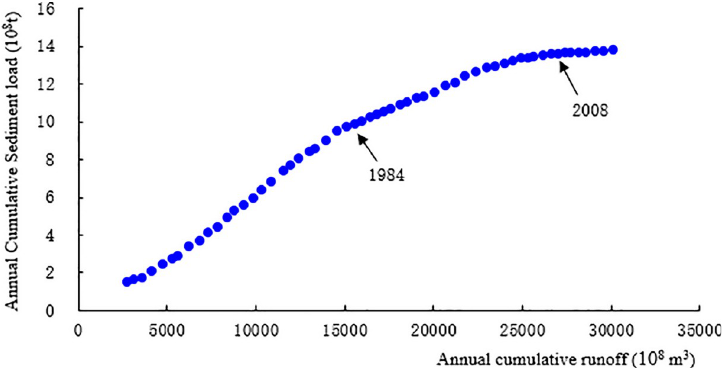
Fig 3. Double cumulative graph of annual runoff and sediment discharge at Wu Long